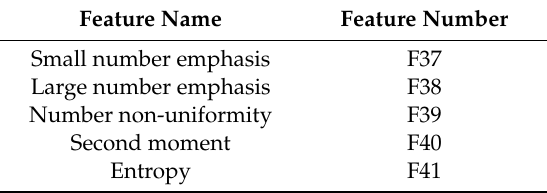
Table 7. Neighboring gray level dependence matrix feature